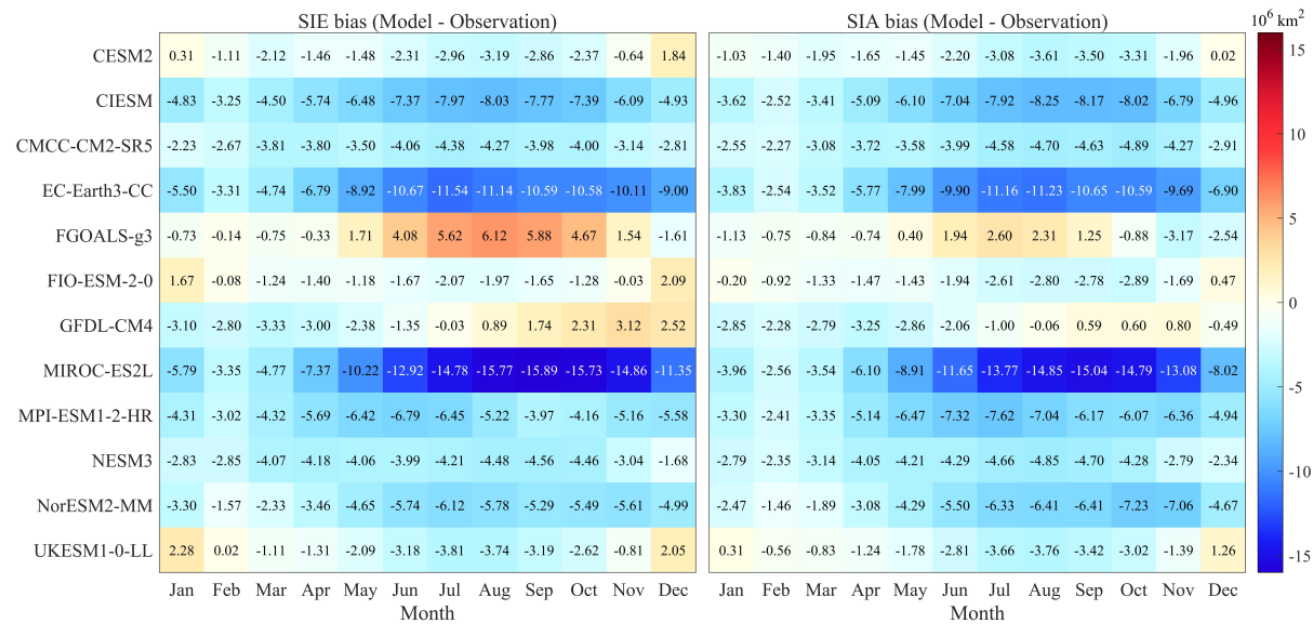
Figure 6. Seasonal cycle of SIE ( left ) and SIA ( right ) biases between the CMIP6 models and the observation during 2015–2021.